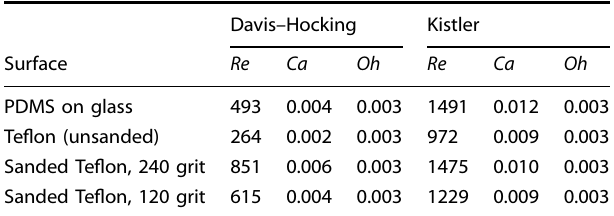
Table 3. Liquid properties used in simulation for water (subscript l ) and air (subscript g ).